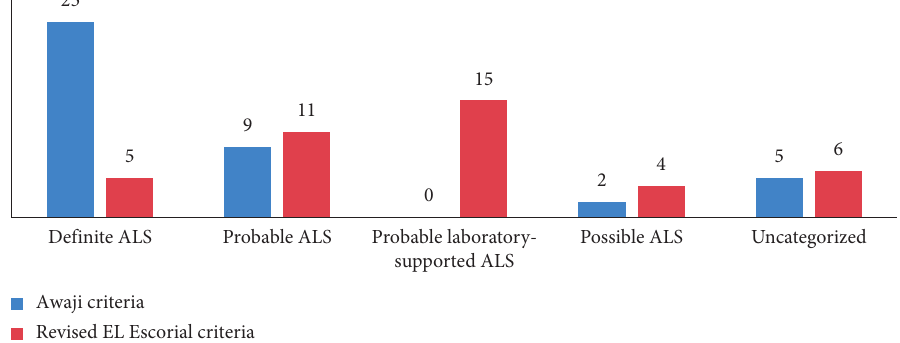
Figure 2: Diagnostic categories for ALS patients with a duration of evolution of the disease from 0 to 6 months, according to the AC and rEEC.